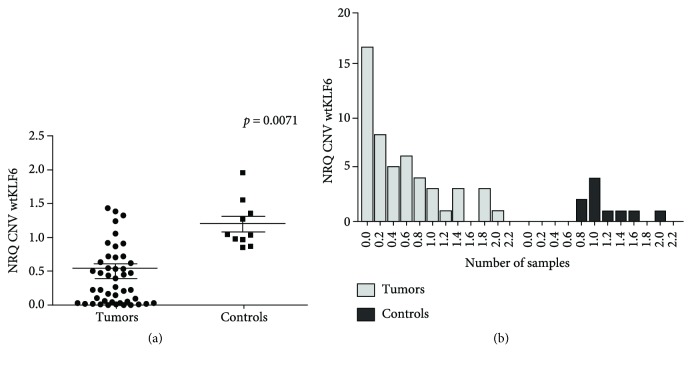
Copy number variation of wtKLF6 in tumors and normal tissues. The normalized copy number variation (CNV) of the KLF6 wild-type isoform in tumors versus normal tissues (a) and the histogram representing the distribution of NRQ values in tumors and controls (b).